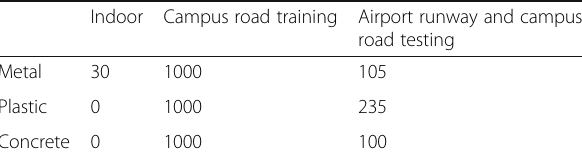
Table 1 Statistics of the FOD